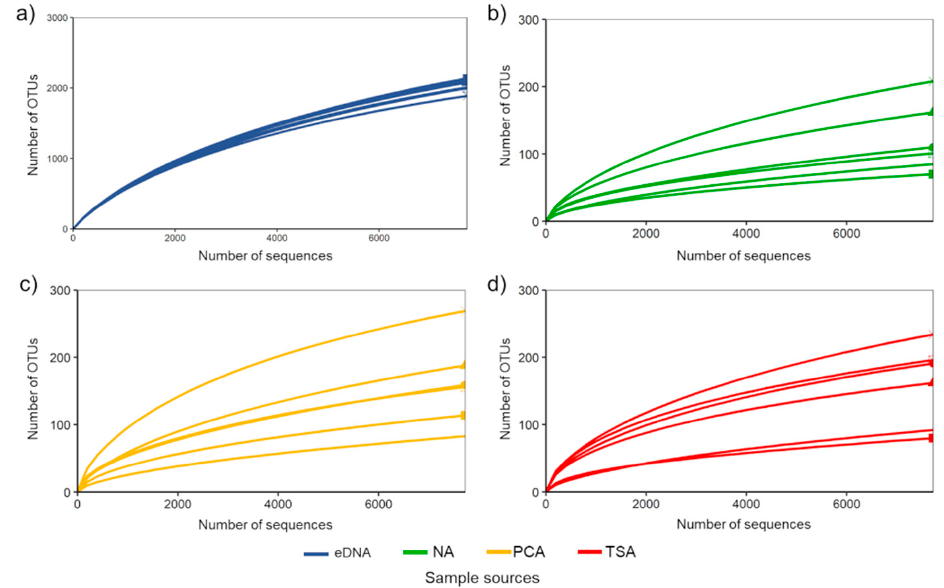
Figure 2. Rarefaction curves of observed bacterial OTUs recovered from ( a ) eDNA and enrichment cultures based on ( b ) nutrient agar (NA), ( c ) plate count agar (PCA) and ( d ) tryptone soy agar